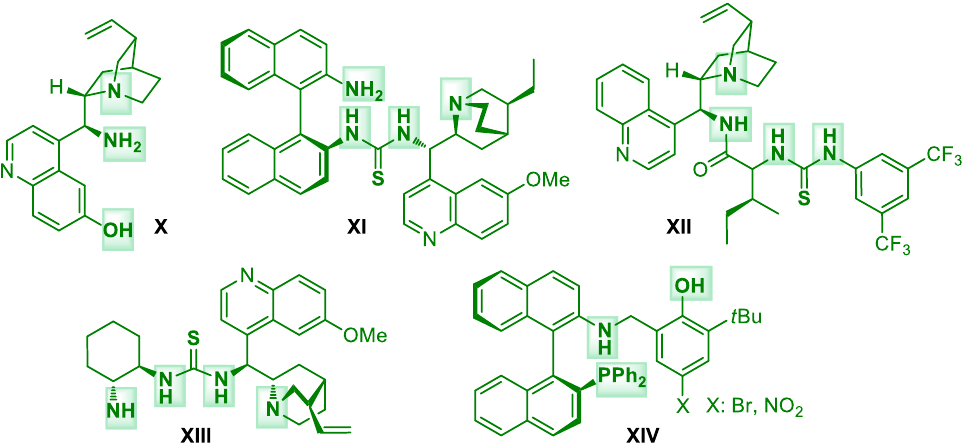
Figure 5. Catalytic structures proposed as trifunctional organocatalysts: X [30], XI [108], XII [109], XIII [110] and XIV [111].